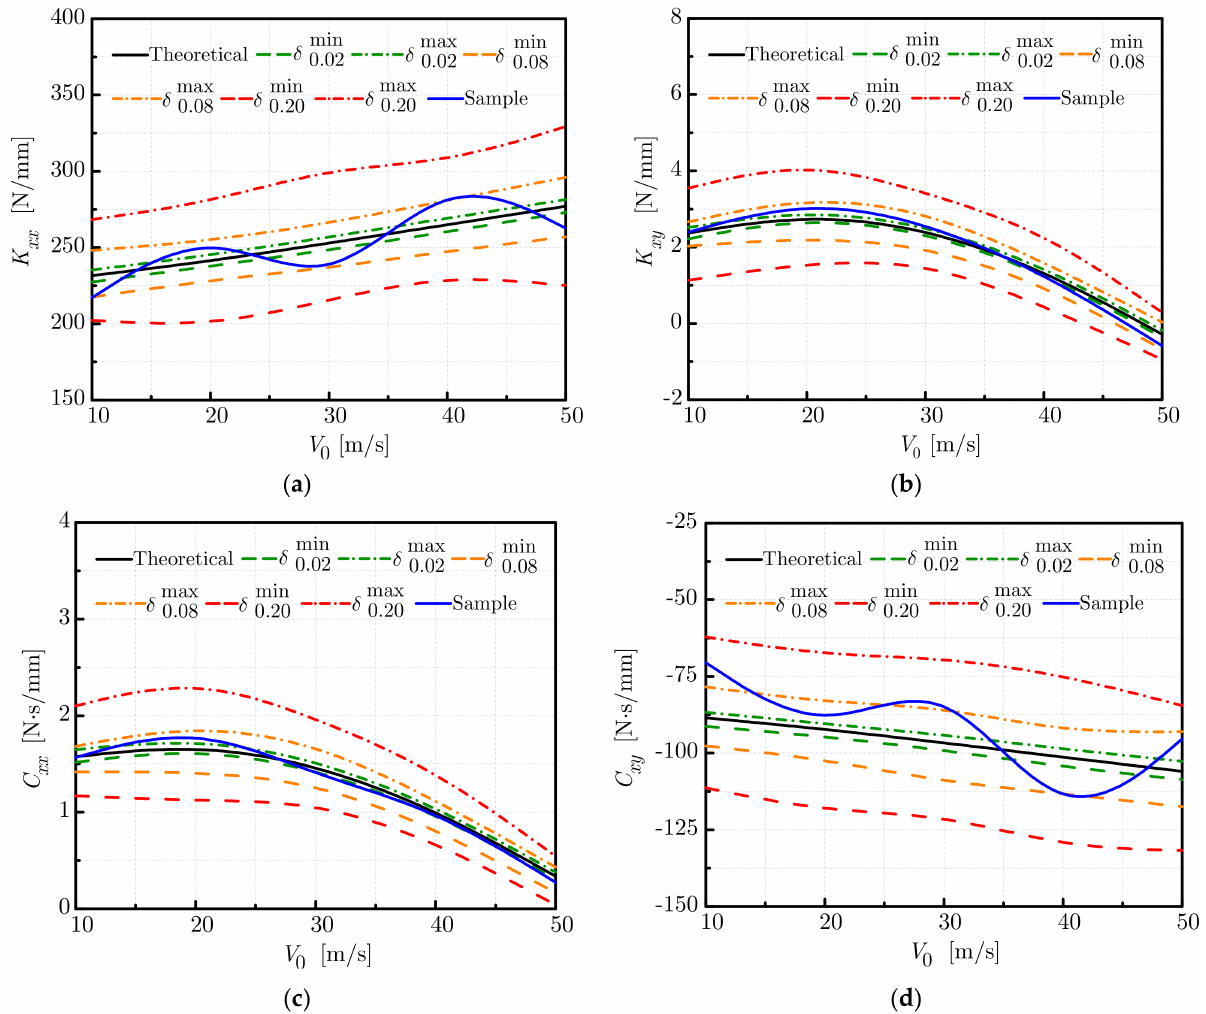
Figure 8. The envelopes of dynamic coefficients against inlet whirl velocity for δ R = 0.02, 0.08, and 0.20, where ( a ) is K xx , ( b ) is K xy , ( c ) is C xx , and ( d ) is C xy